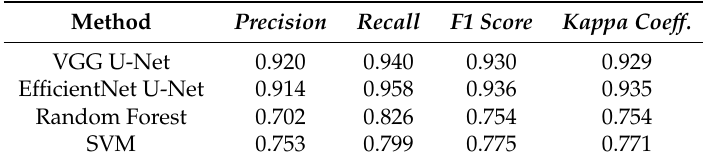
Table 2. Quantitative assessment of the predicted labels on the test data using F1 score and Kappa coefficient. The test data consists of 1311 tiles of size 256 ×